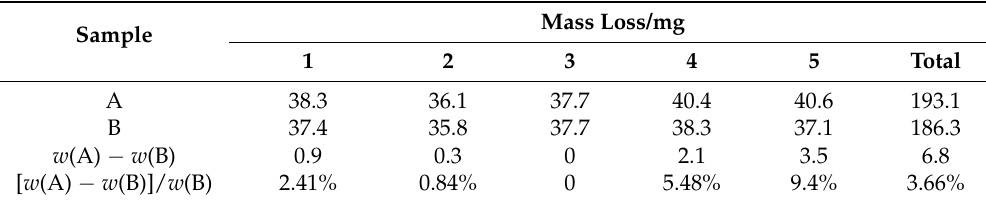
Table 3. Mass loss for samples A and